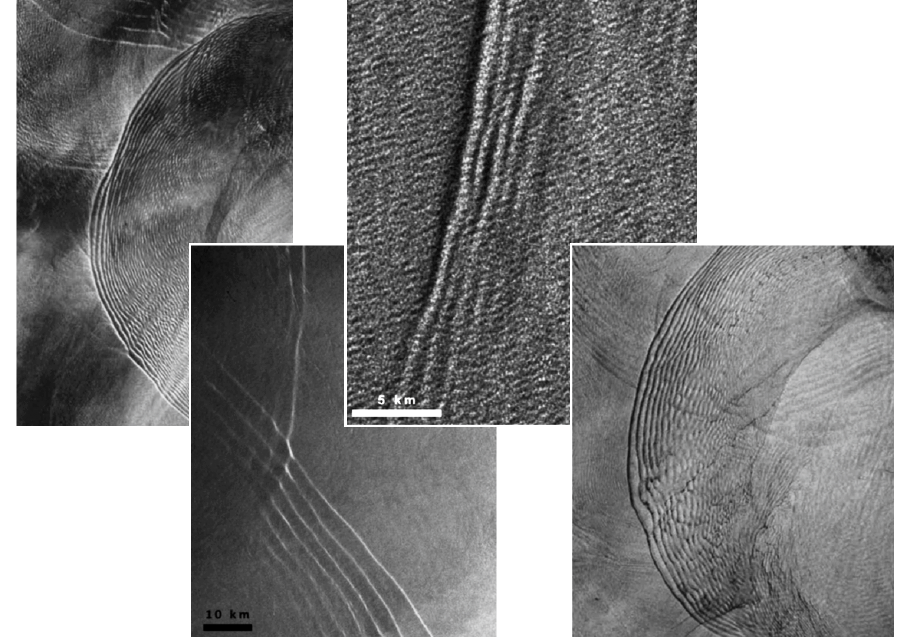
Figure 10. Different image signatures of nonlinear internal waves [63]. Top left and bottom right : TerrasAR–X images over the Gulf of Main west of Cape Cod acquired, respectively, on the 23rd of June and 3rd of July, both in 2008. Top right : ERS–1 SAR image over the Mozambique Channel acquired on the 24th of September 2001. Bottom left : ENVISAT–ASAR image over the Andaman Sea acquired on the 18th of November 2006. The propagation direction is from right to left, except the ENVISAT–ASAR image, in which the interaction can also be seen between the two wave packets propagating predominantly from left to right.